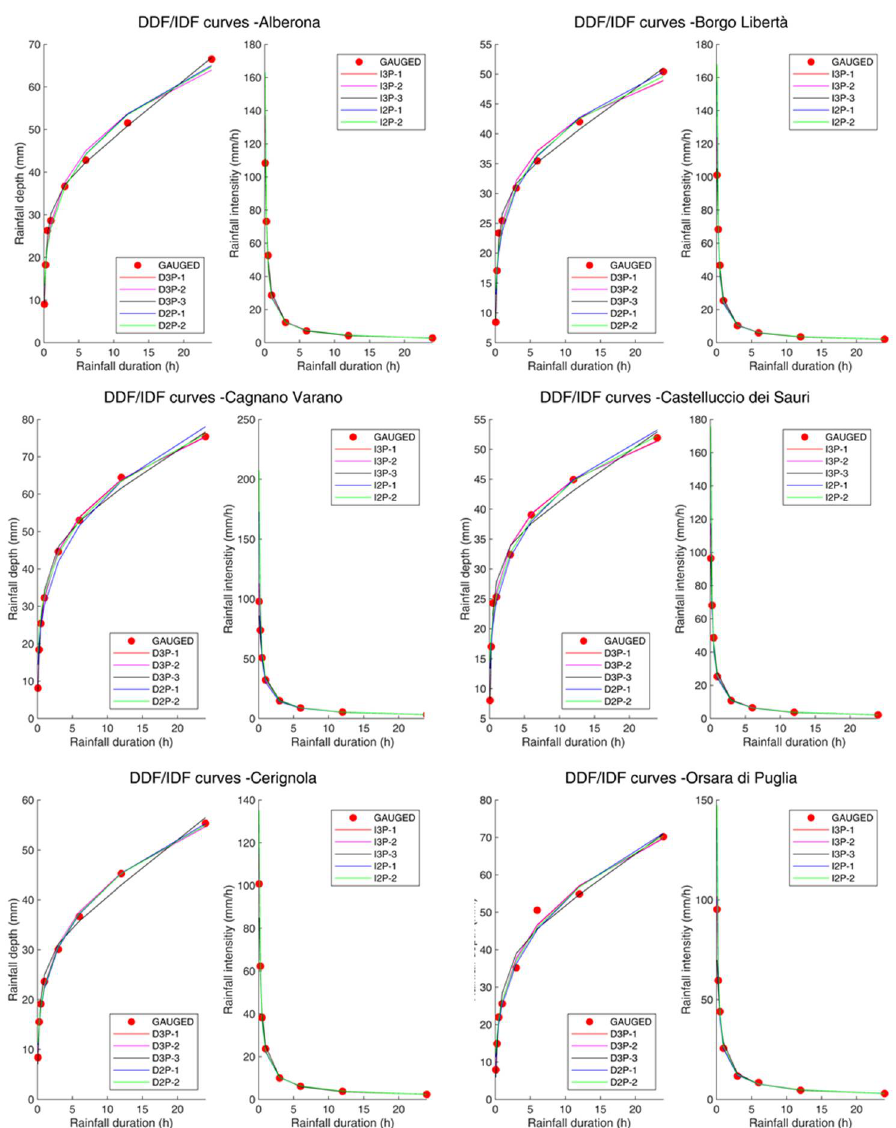
Figure 2 . Fitted DDF and IDF curves Figure 2. Fitted DDF and IDF